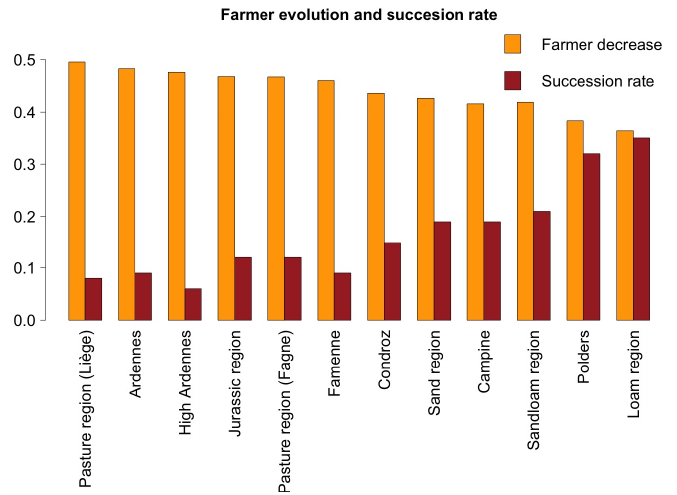
Figure 11. Percentage decrease of farmers between 2015 and 2030 and the succession rate used for each agricultural region.